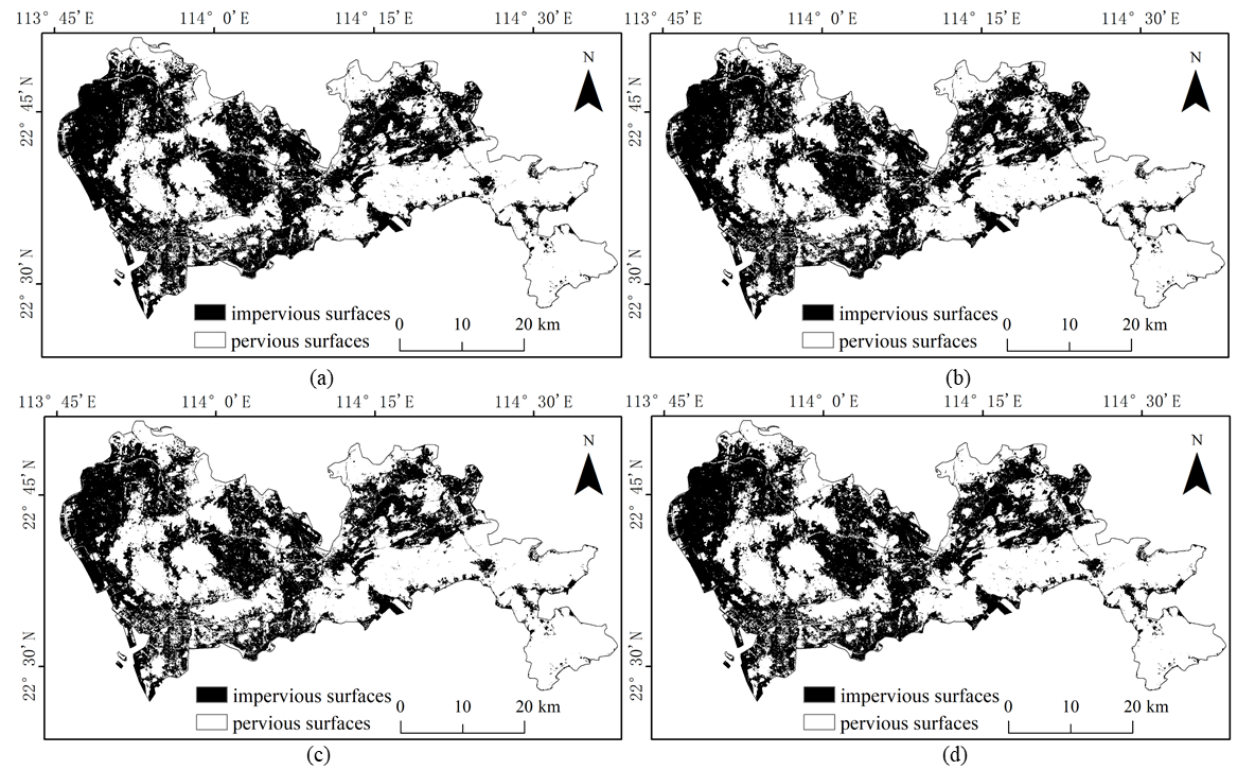
Figure 11. Results of impervious surface extraction with BDA: ( a ) 80,000 samples; ( b ) 120,000 sam- ples; ( c ) 160,000 samples; ( d ) 200,000 samples.